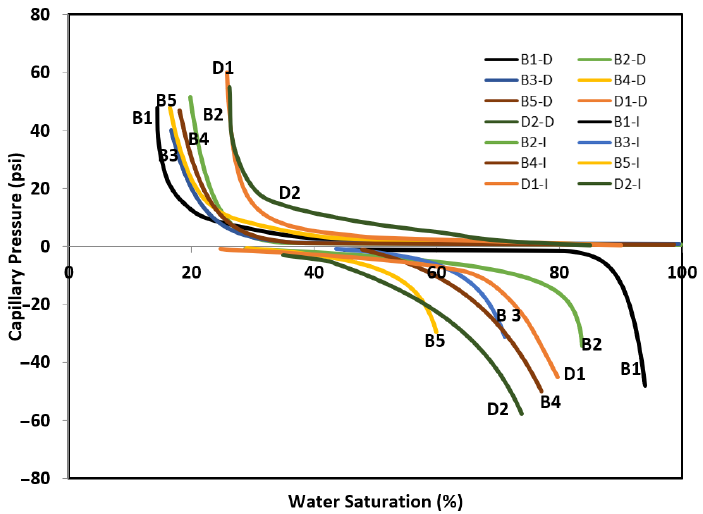
Figure 3. Capillary pressure curves for Berea and Silurian dolomite samples.